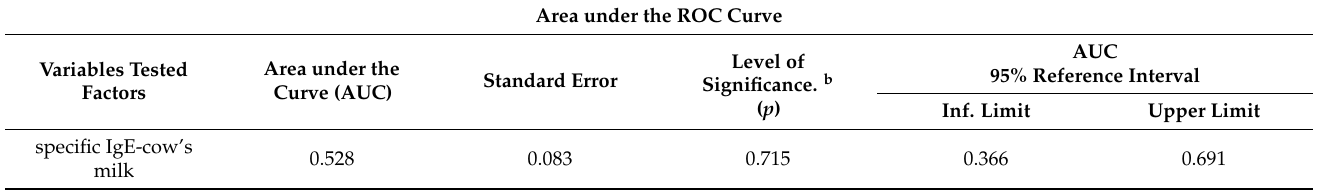
Table 6. Estimated parameters in the analysis of the ROC curve for specific IgE-cow’s milk/disease remission. Area under the ROC Curve Variables Tested